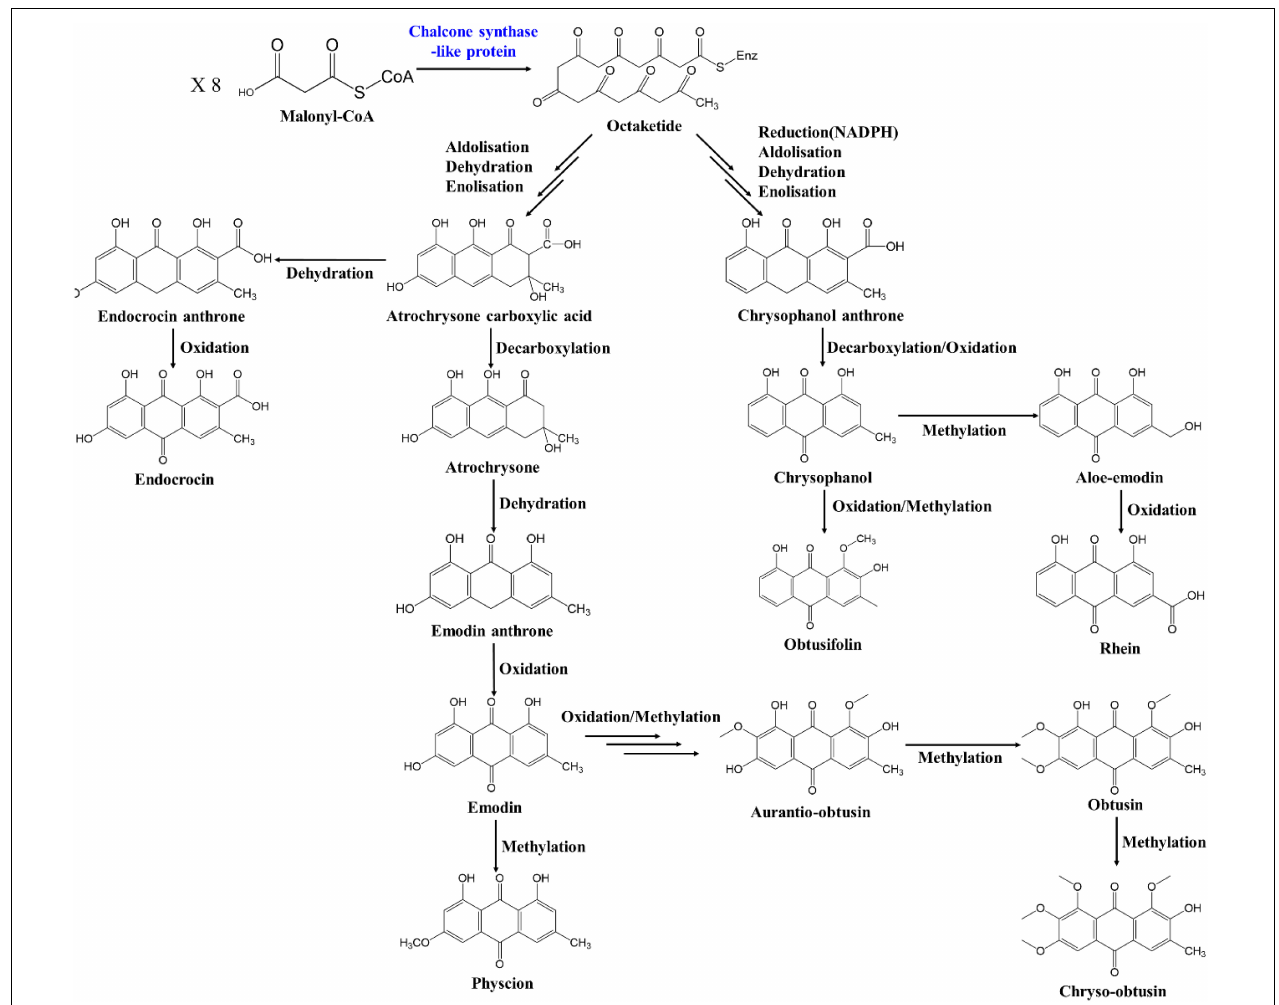
FIGURE 6 | Putative anthraquinone biosynthesis pathways in Senna